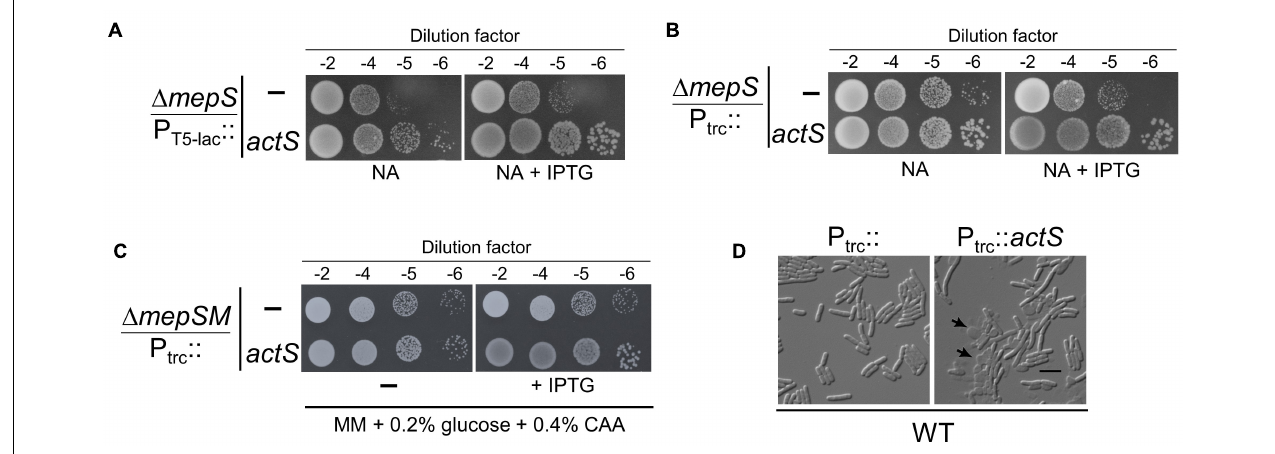
FIGURE 2 | Phenotypes caused by ActS overexpression. (A) Growth of (cid:49) mepS mutant carrying the ASKA vector (P T5 − lac ::) or vector encoding actS (P T5 − lac :: actS ) on NA plates supplemented with 10 µ M isopropyl-thiogalactopyranoside (IPTG) at 37 ◦ C. (B) Growth of (cid:49) mepS mutant carrying the empty vector (P trc ::) or vector encoding actS (P trc :: actS ) on NA plates supplemented with 20 µ M IPTG at 37 ◦ C. (C) (cid:49) mepS (cid:49) mepM double mutant harboring either pTRC99a (vector) or vector encoding actS (P trc :: actS ) were grown in minimal media (MM) and tested for viability on MM plates supplemented with 0.2% glucose, 0.4% casamino acids (CAA), and 20 µ M IPTG at 37 ◦ C. (D) WT cells carrying the vector (P trc ::) or vector encoding actS (P trc :: actS ) were grown in LB supplemented with 50 µ M IPTG at 37 ◦